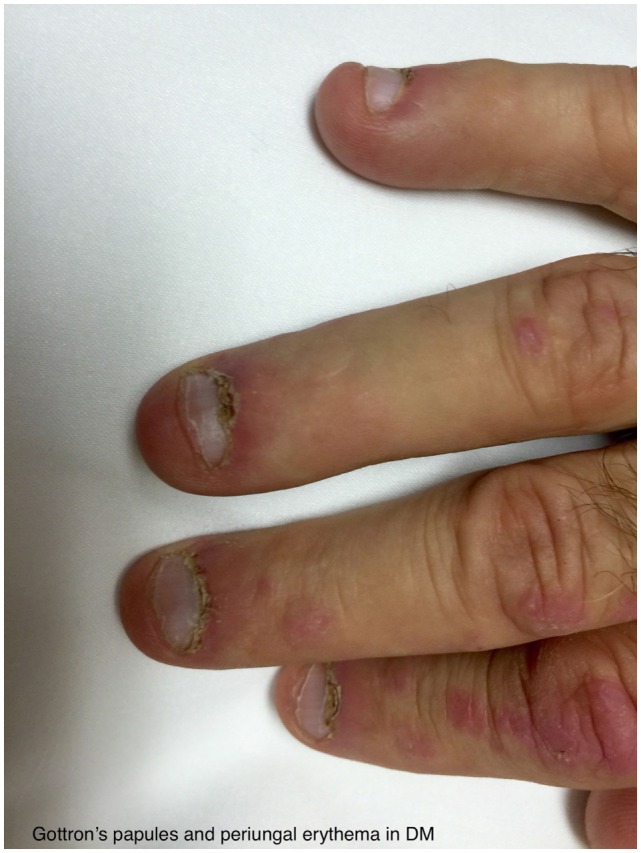
Gottron’s papules and periungal erythema in DM.